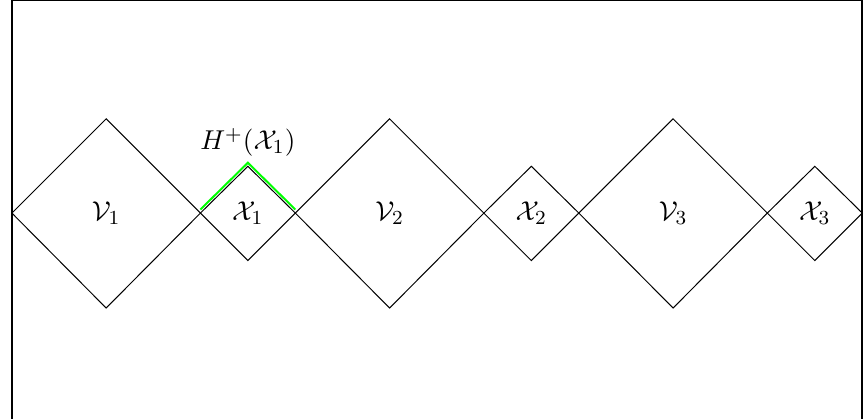
Figure 9. On the boundary cylinder, the causal complement of V 1 ∪ V 2 ∪ V 3 is made up of three causal diamonds X and X The future horizon of X 1 , X 2 , 3 .